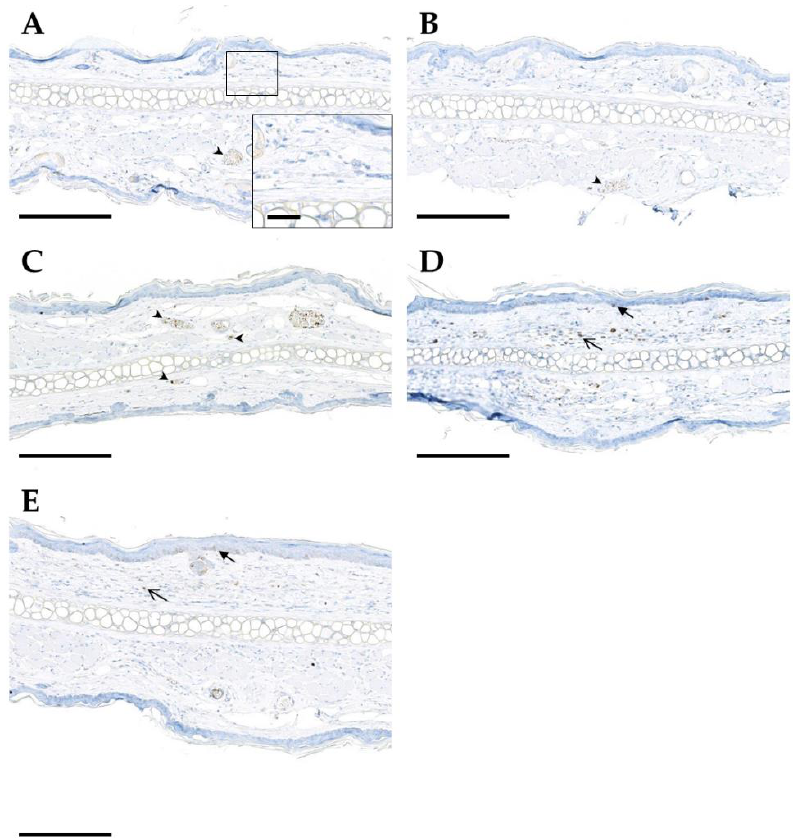
Figure 8. Immunohistochemical detection of TGF β1 (brown color) in mouse ear sections on day 92 following hypofractionation with different doses per fraction: sham ( A ), 5 Gy ( B ), 10 Gy ( C ), 20 Gy ( D ), 30 Gy ( E ). Positive endothelial and intravascular inflammatory cells are indicated by arrowheads, epidermal immunoreactivity by closed arrows, and immunoreactivity of dermal cells by open arrows. Paraffin sections of murine ears are shown. Chromogenic substrate: diaminobenzidine (DAB), nuclear counterstain: hematoxylin. Scale bar: 200 µm (for zoom-in image 20 µm). Mouse ears irradiated with 5 Gy per fraction had a maximum thickness of 317.9 ± 8.2 µ m